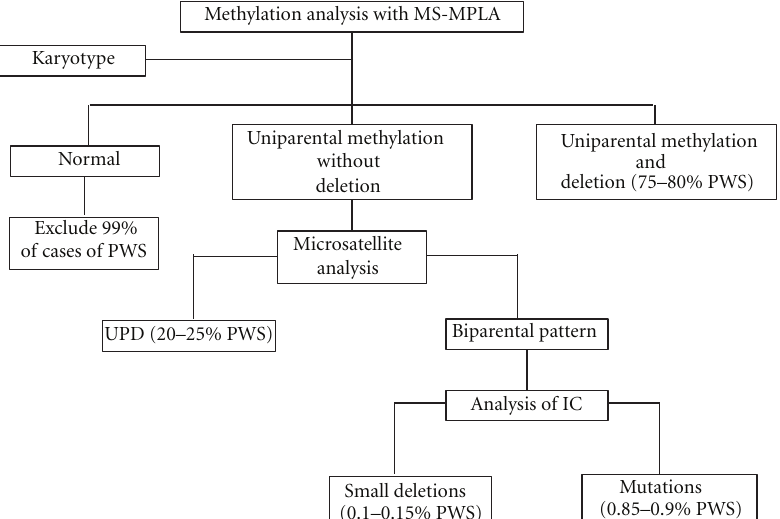
Figure 2: Algorithm for genetic testing for PWS. MS-MPLA: methylation-specific-multiplex ligation-dependent probe amplification analysis. UPD: uniparental disomy. IC: imprinting